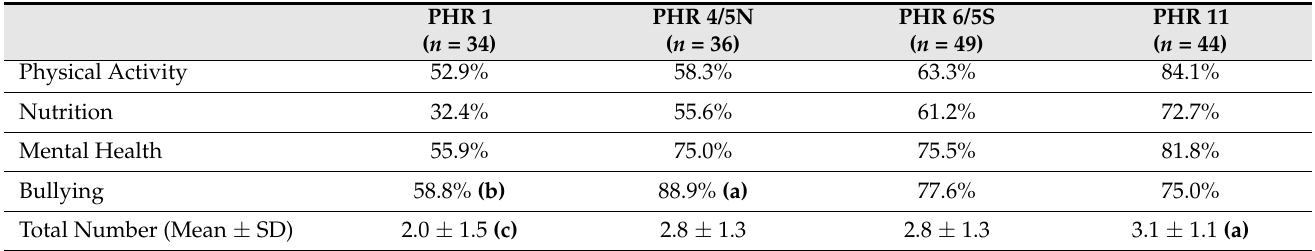
Table 3. CIPs ( n = 163) including each topic area by Public Health Region (PHR).